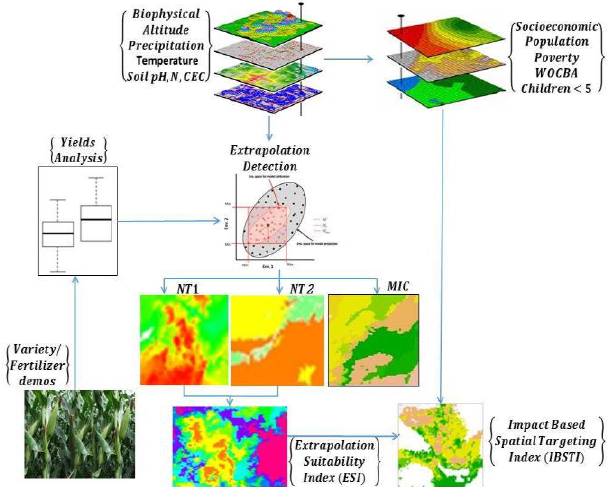
Figure 2. Flow Chart for the statistical